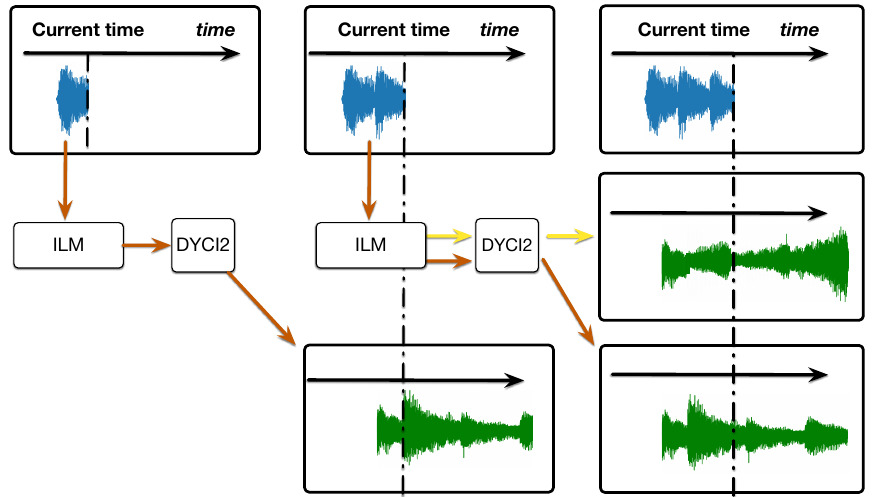
Figure 3. The intelligent listening module (denoted ILM) sends a predicted chord sequence at each beat. The DYCI2 library handles this short-term scenario for each beat and adapts the generation